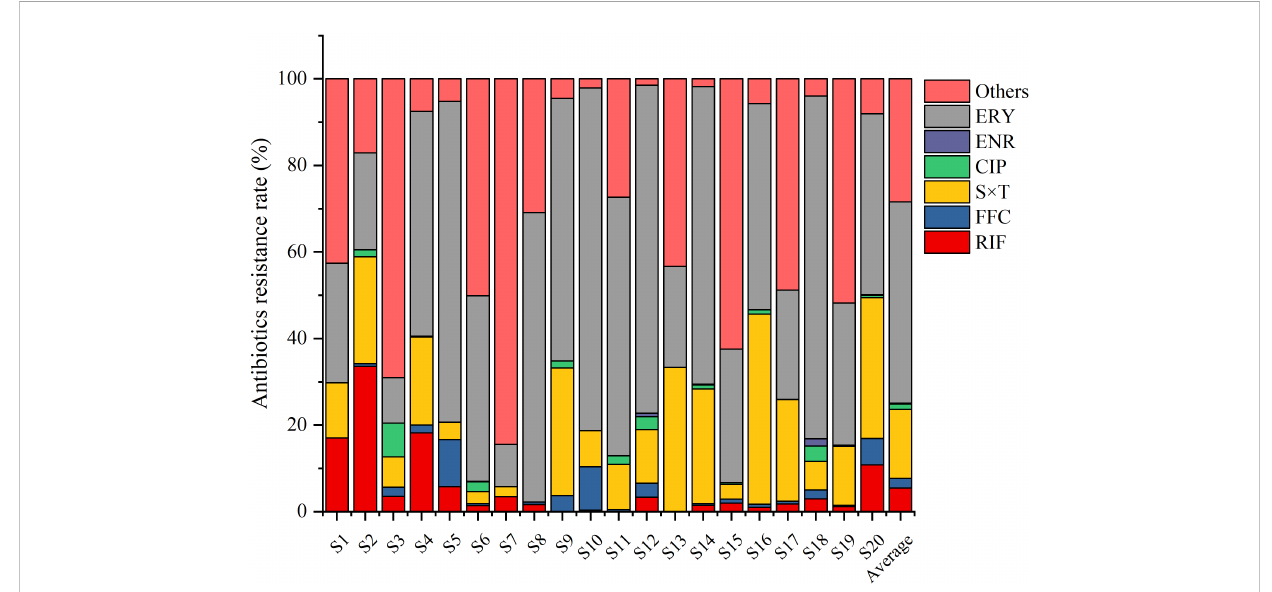
FIGURE 2 Bacterial resistance rates to rifampin (RIF), fl orfenicol (FFC), sulfamethoxazole+trimethoprim (S×T), cipro fl oxacin (CIP), enro fl oxacin (ENR), and erythromycin (ERY) in different sea bass ponds. The bacterial resistance rates were de fi ned as the number of bacteria grown on plates with one antibiotic/total number of bacteria grown without